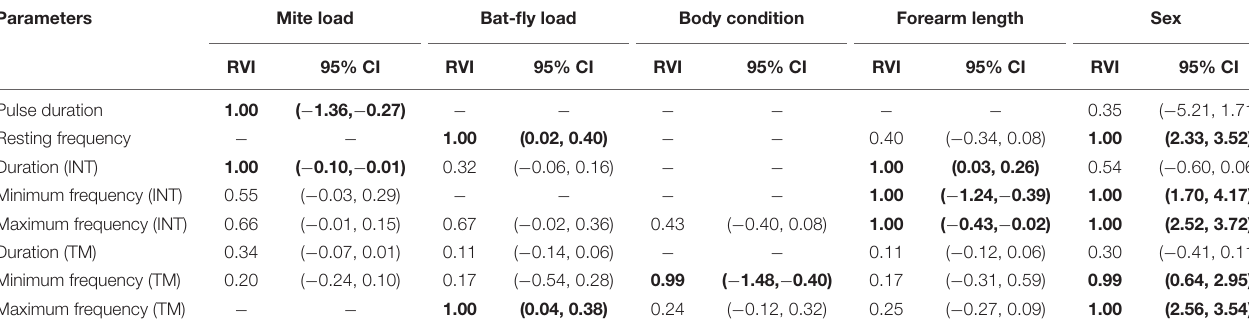
TABLE 2 | Model-averaged parameter estimates of strongly supported linear models ( (cid:49) AICc ≤ 2) explaining the inter-individual variation of echolocation pulses in Rhinolophus sinicus . Parameters Mite load Bat-fly load Body condition Forearm